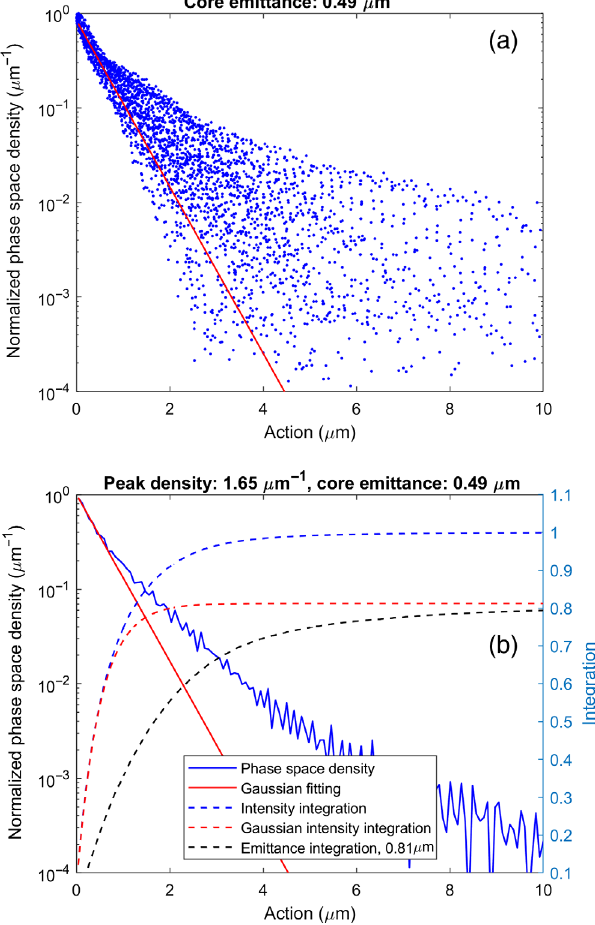
FIG. 7. Gaussian core analysis of 1 nC phase space measured at 4-dB camera gain, (a) scattering plot, (b) binning plot. The absolute phase space density is normalized to the max value at action J ¼ 0 . The Gaussian fitting is based on Eq. (10). The emittance integration is based on Eq.